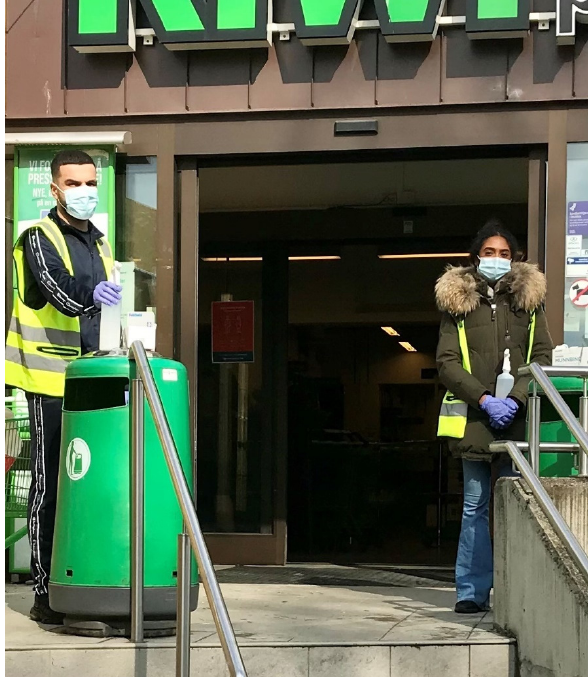
Figure 1. Corona hosts at work.